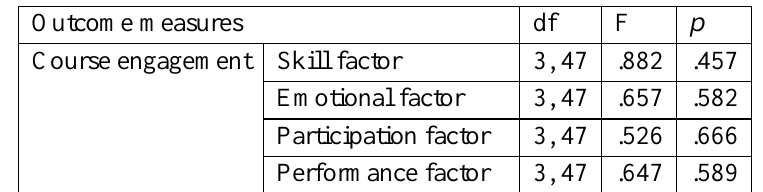
ANOVA Results for Course Engagement and